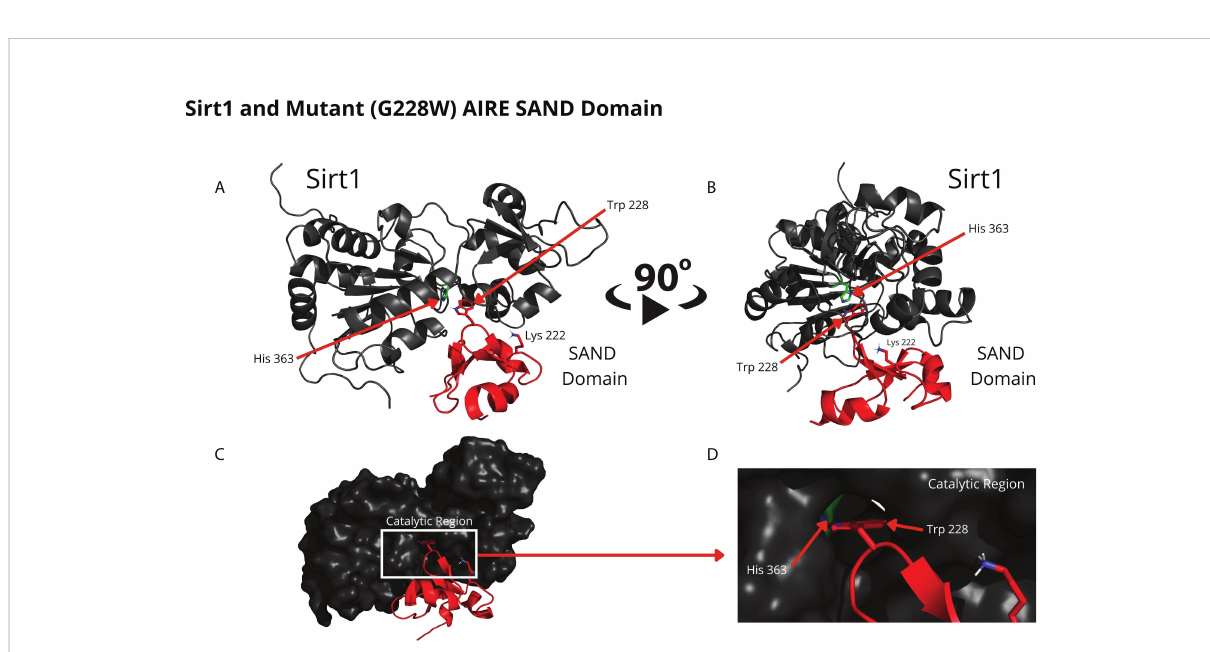
FIGURE 3 The blind docking output of the mutant AIRE SAND domain shows that this domain interacts with the catalytic region of the SIRT1 (His363 in green) protein through its mutant residue W228 (Trp228). The structures of the mutant SAND domain (in red) and SIRT1 (in dark gray) are represented in (A, B) In this representation, the mutant AIRE SAND domain interacts with the catalytic region through its mutant residue W228 (Trp228), and the lysine 222 (Lys222) residues are presented with its side chain. In (C, D) the same complex is represented with the surface of SIRT1 highlighted. (D) represents the catalytic region of SIRT1 and its catalytic residue, His363.